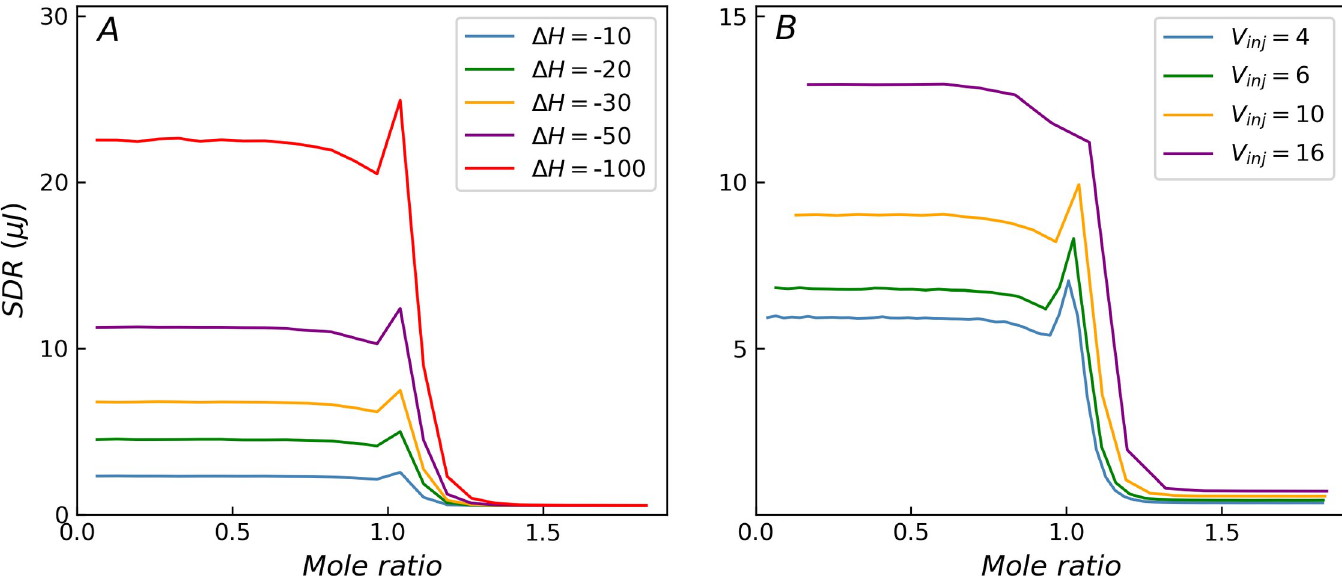
Fig 3. The influence of Δ H and V on the distribution of SDR with c = 1000. (A) As Δ H decreases, the heat residual decreases until the heteroscedasticity disappears. inj (B) When the injection volume is large, the SDR peak weakens.